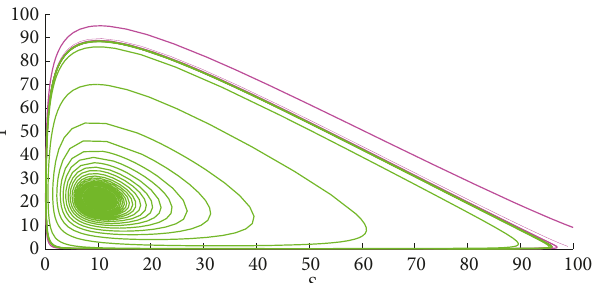
Figure 5: Phase portrait of the system when there exists a stable limit cycle, which lies in the junction of the magenta and green lines.